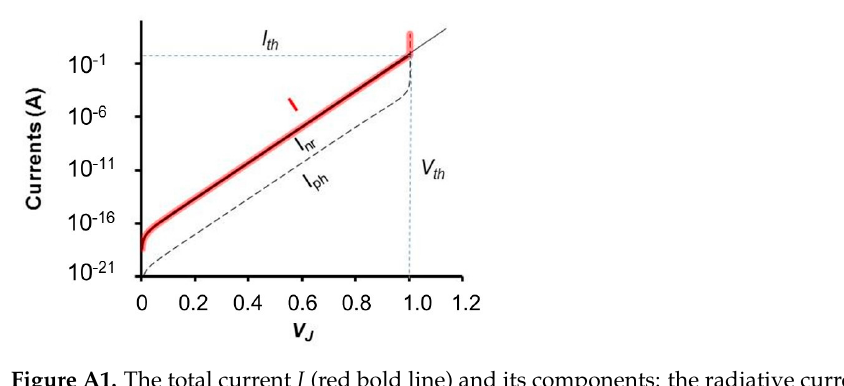
Figure A1. The total current I (red bold line) and its components: the radiative current I ph (dashed line) and the non-radiative current I nr (thin solid line). The threshold voltage V th and current I th are also indicated as the coordinates of the sharp transition in I .